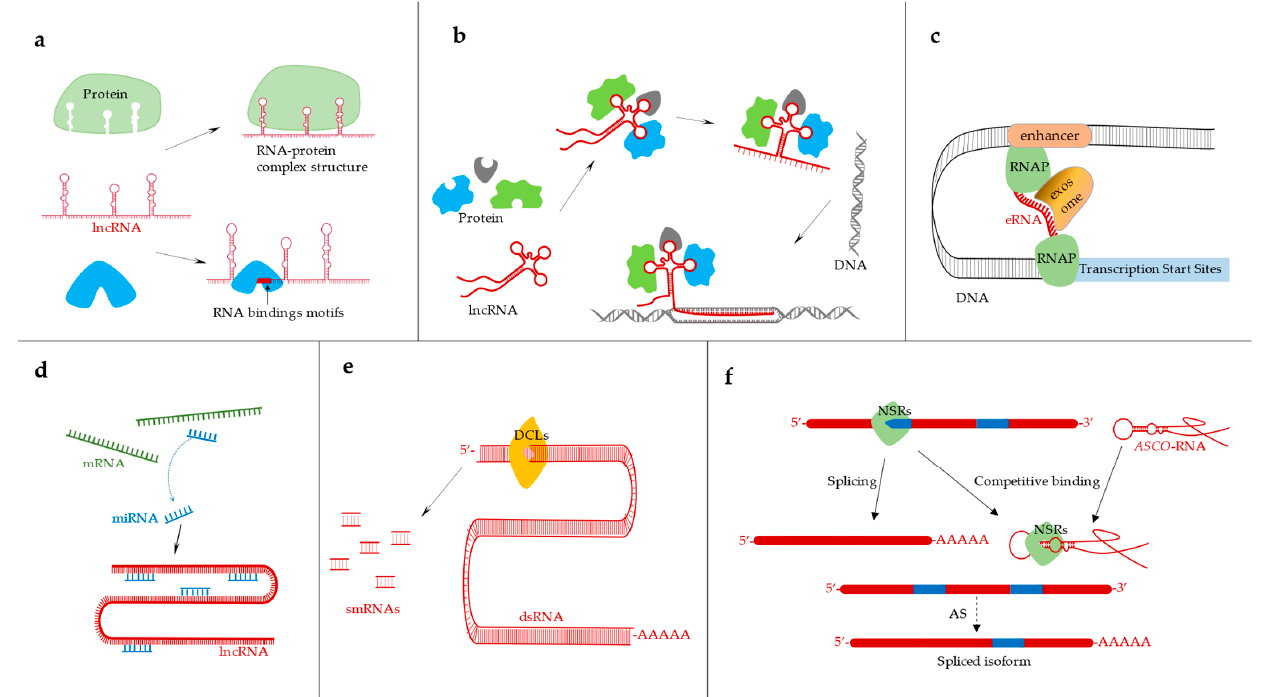
Figure 2. The action mode and function mechanism of lncRNA. ( a ) The expression of lncRNA may require special secondary structure or specific binding motifs. ( b ) lncRNA can act as a molecular scaffold to shorten the distance between different protein complexes and combine with specific sequences to play a special function. ( c ) The eRNAs expressed by enhancers are regulated by exosomes, which can combine with promoters and enhancers to affect the topology of DNA and finally change the expression of genes [61]. ( d ) lncRNA acts as a molecular sponge by adsorbing miRNA to regulate the expression of downstream genes. ( e ) Double stranded lncRNA can be used as a precursor of smRNA (small miRNA). ( f ) ASCO -lncRNA (AS competitor long noncoding RNA) in Arabidopsis can affect the expression of proteins regulating alternative splicing. ASCO acts as a bait to compete with mRNA to bind to NSR (nuclear speckle RNA) splicing regulators. ASCO -RNA and NSR-binding proteins compete for the binding of their targets, and hijacking NSR changes for the splicing pattern of mRNA targets regulated by NSR and produces alternative splicing isomers [73].